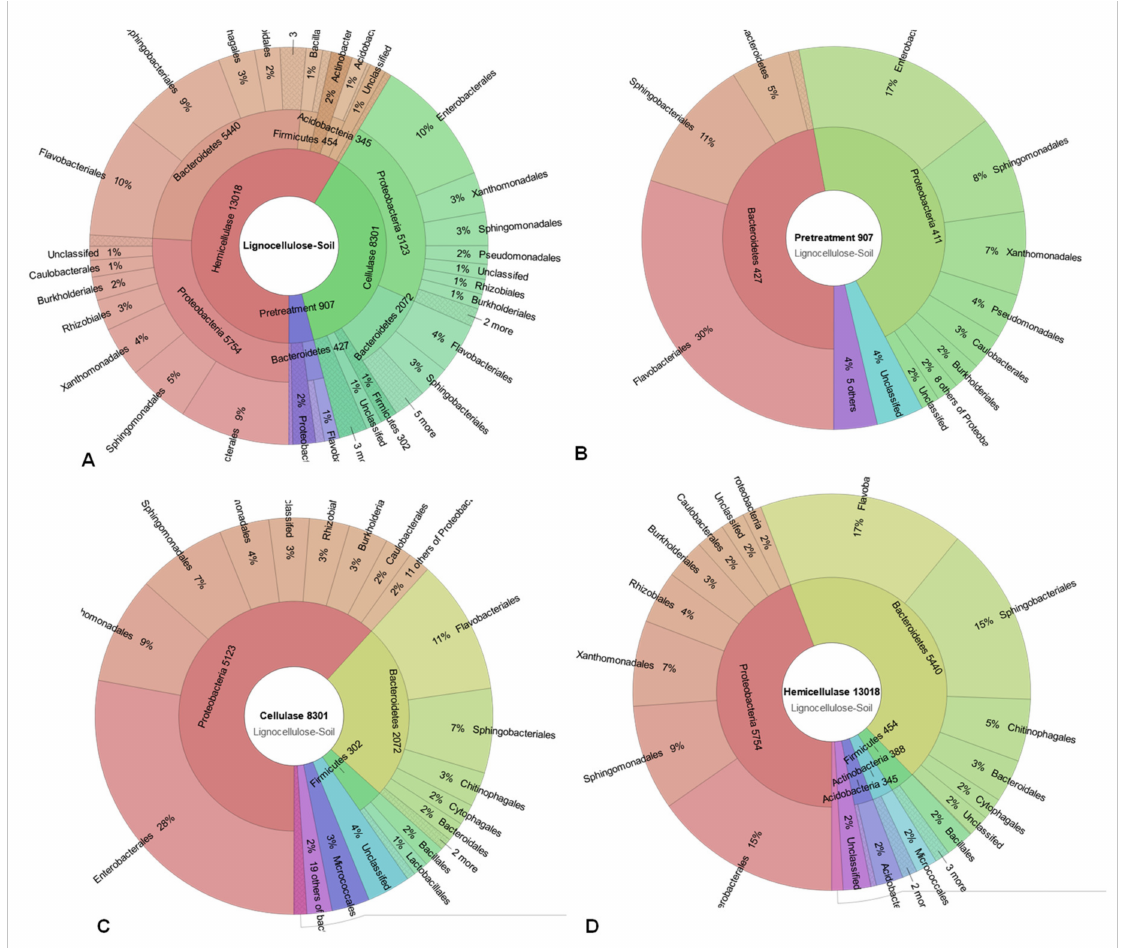
Figure 5. ( A ) Analysis of community structure of the humus bacteria harboring genes for lignocel- lulose degradation at phylum and order level, ( B ) lignocellulose pretreatment, ( C ) cellulase, and ( D ) hemicellulase. The number indicates the percentage and the number of